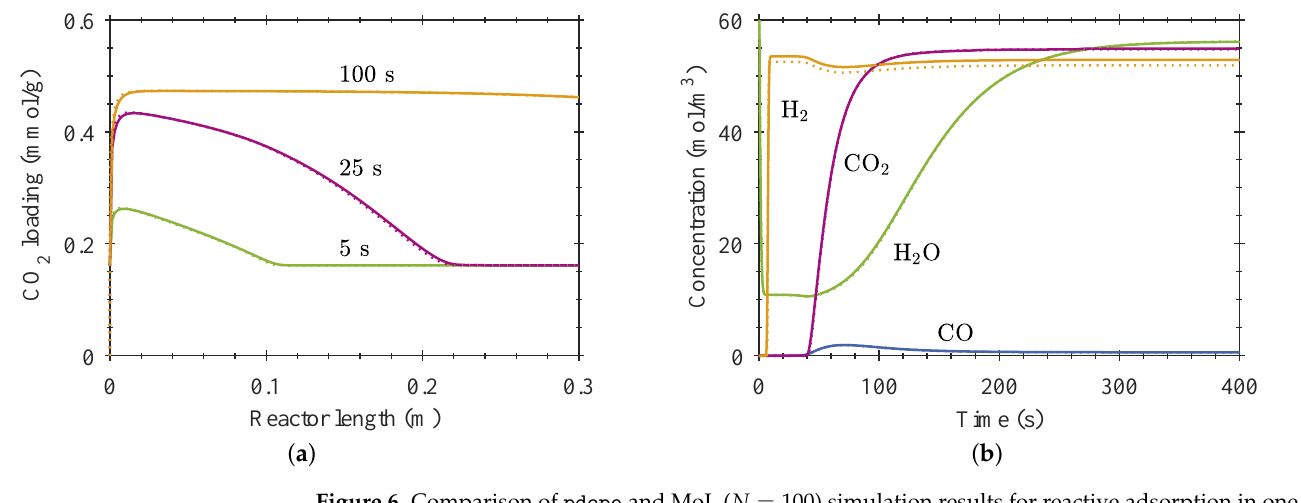
Figure 6. Comparison of pdepe and MoL ( N = 100) simulation results for reactive adsorption in one reaction chamber. ( a ) CO 2 loading at various adsorption times as a function of the reactor length, and ( b ) bulk phase concentrations at reactor outlet as a function of time. Solid lines: MoL; dotted lines: pdepe .